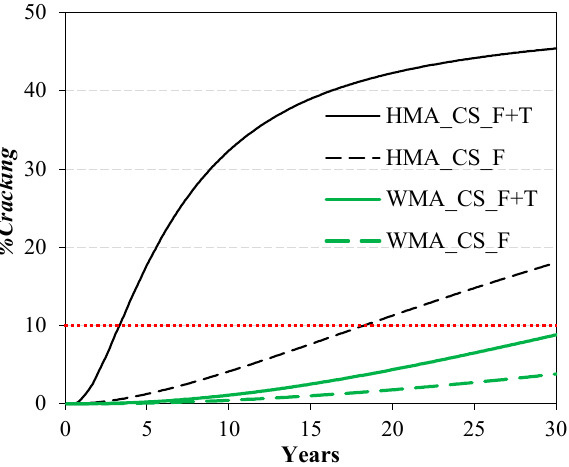
Figure 11. Cracking evolution on the pavement surface over 30 years with cracked subbase. Table 5. Outcomes of the FlexPAVE simulations in the case of cracked subbase.